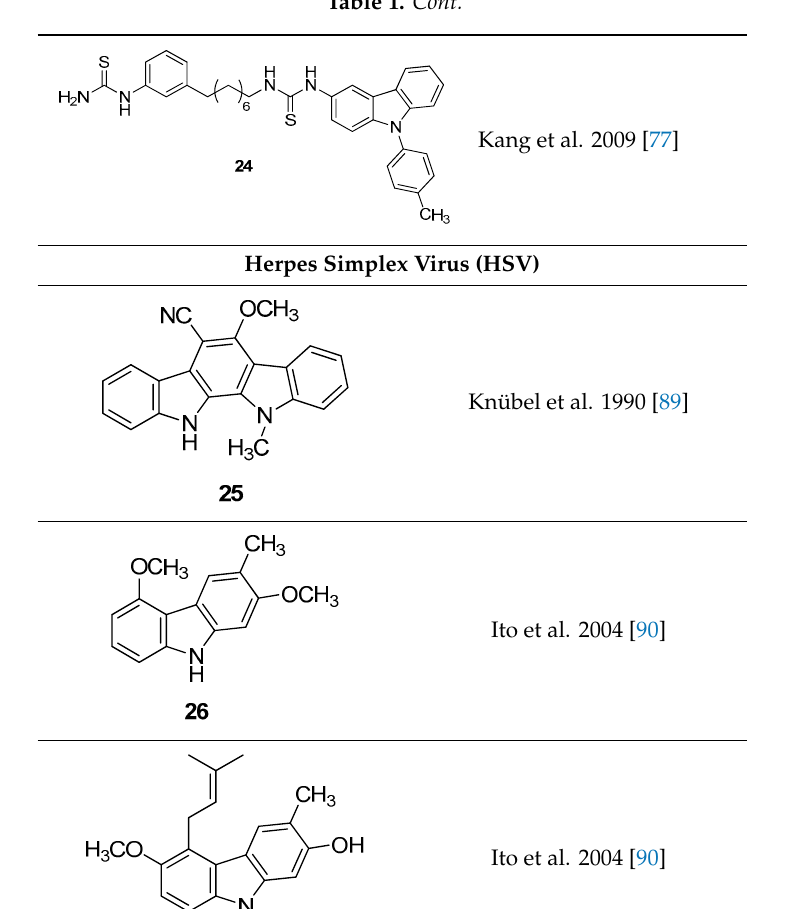
Molecules 2019 , 24 ,